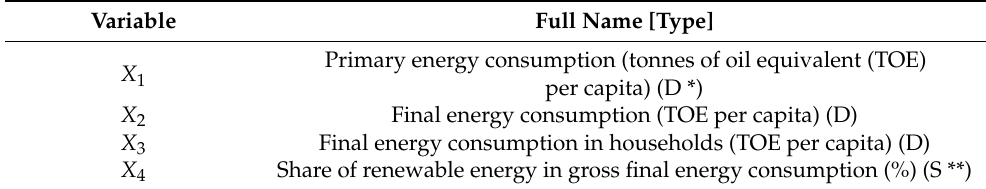
Table 3. Sustainable energy consumption assessment